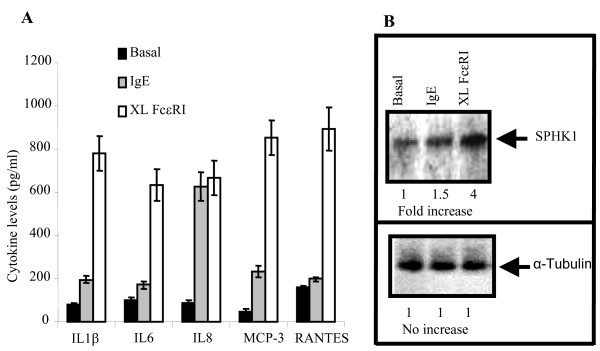
Protein expression analysis. A. ELISA for selected Cytokines and Chemokines. Cytokine and chemokine generation/release was determined from control-unstimulated mature mast cell (Basal); following IgE-sensitization (IgE) for 24 hours; and FcεRI aggregation by addition of the anti-human IgE to sensitized cells for 24 hours (XLFcεRI). Cell culture supernatants were analyzed for bioactive IL-1β; IL-6; IL-8; MCP-3 and RANTES by ELISA. Results shown are the mean plus the standard deviation of triplicate measurements and are representative of four separate experiments. B. Western Blot analysis of SPHK1. Upper panel; differential expression of SPHK1 was assessed by Western blot on lysates from control unstimulated cells (Basal); following IgE-sensitization (IgE) for 24 hours; and FcεRI aggregation by addition of the anti-human IgE to sensitized cells for 24 hours (XLFcεRI). Lower panel; the blots were probed for α-tubulin (control for equal loading). Results shown are representative of four separate experiments.